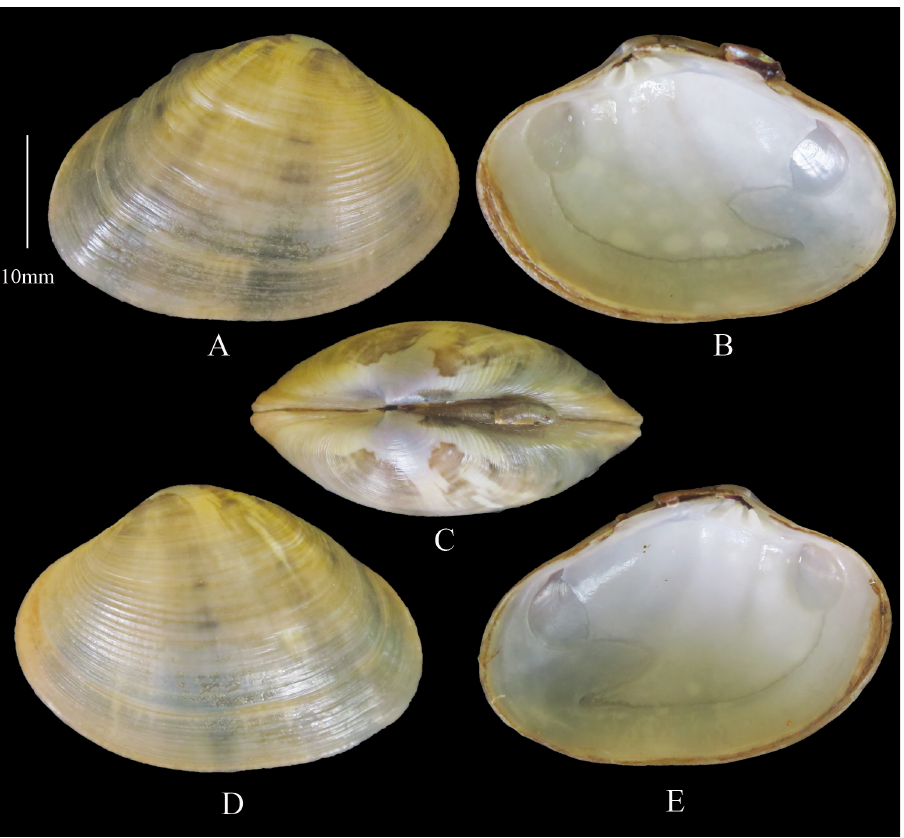
Figure 4. Marcia recens Topotype A right valve dorsal B right valve ventral C dorsal margin D left valve dorsal E left valve ventral (DABFUK), Tuticorin, Tamil